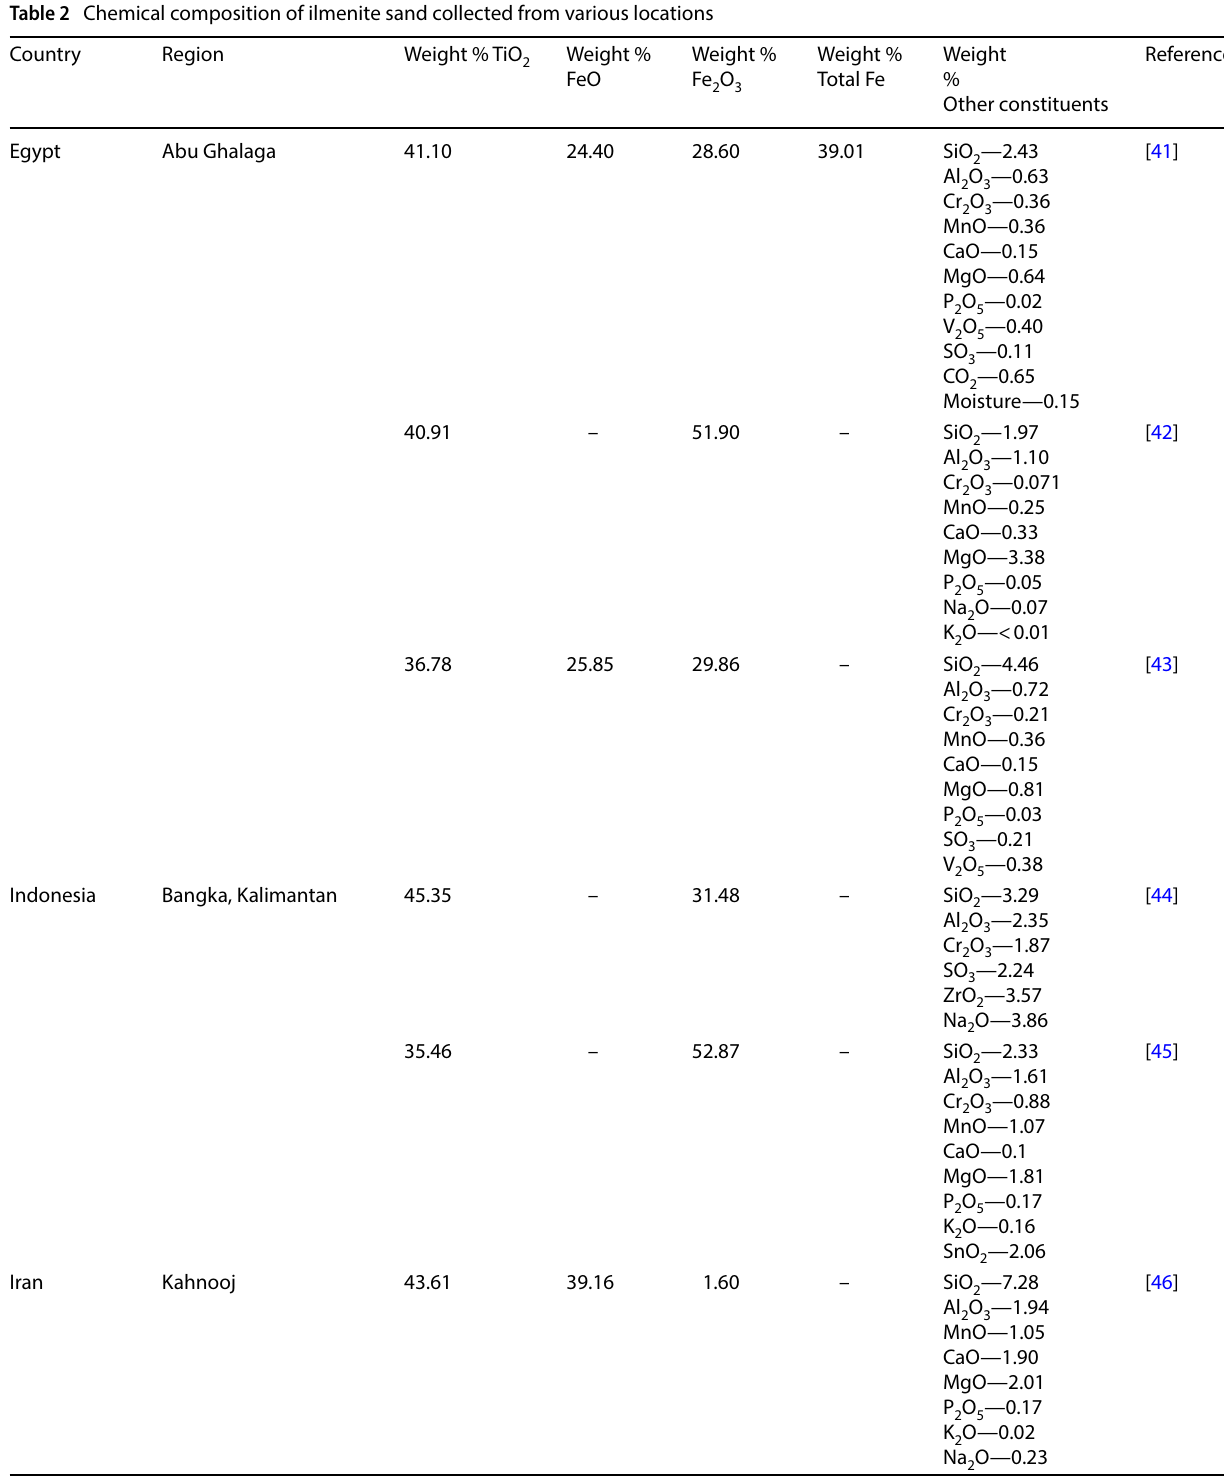
Table 2 Chemical composition of ilmenite sand collected from various locations